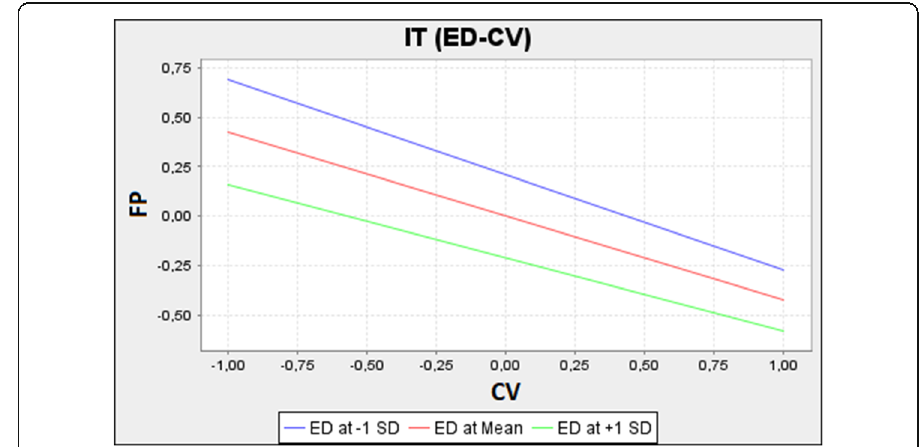
Fig. 4 Moderating effect of ED on CV and FP relationship. FP, financial performance; SD, standard deviation; IT, interaction